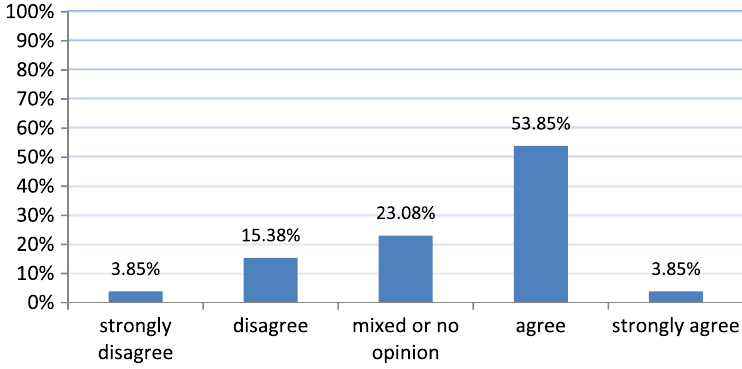
Figure 4. Financial diversification allows the university a significant degree of independence in its decision